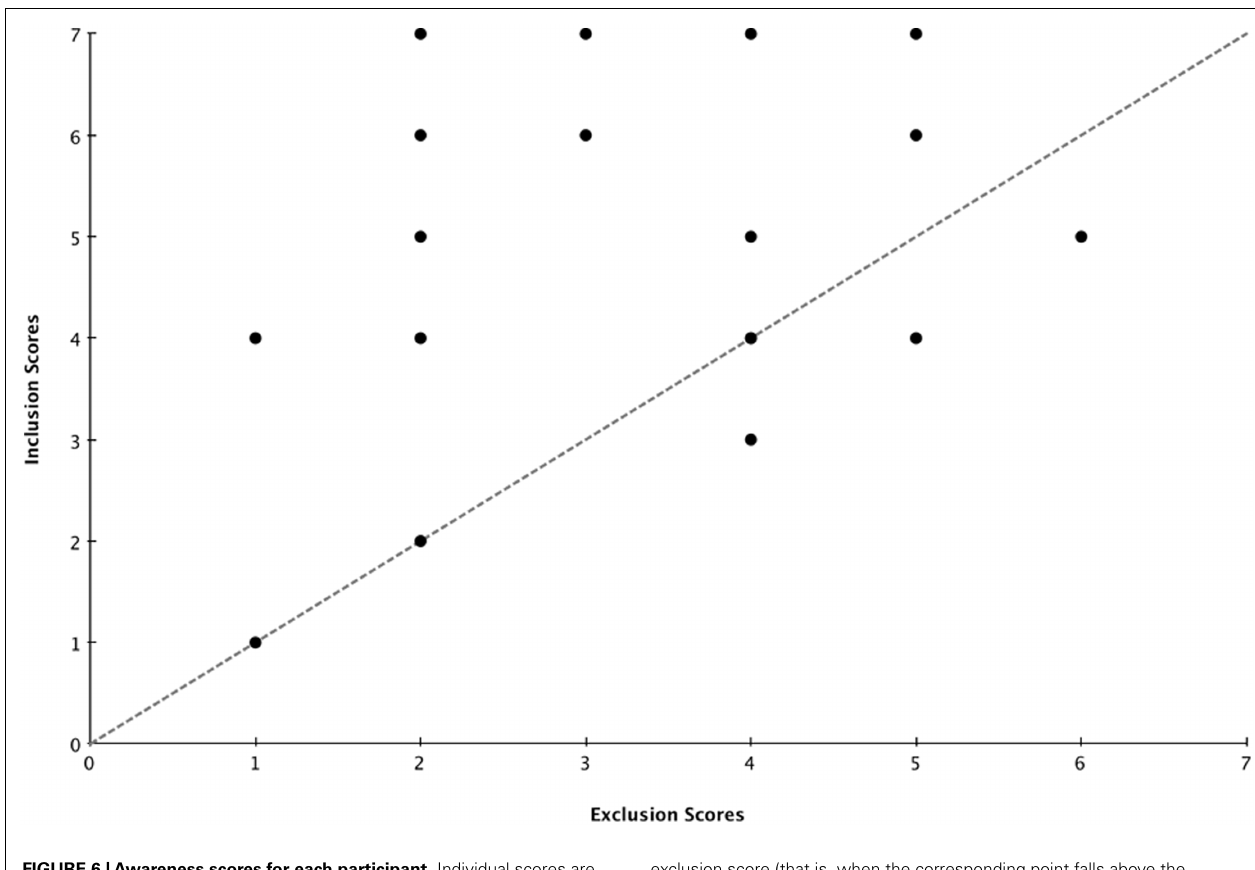
FIGURE 6 |Awareness scores for each participant. Individual scores are represented as points with coordinates corresponding to the frequency with which a word has been correctly accepted under inclusion instructions ( Y -axis) and the frequency with which a word has been incorrectly accepted in the exclusion task ( X -axis).When the inclusion score is higher than the